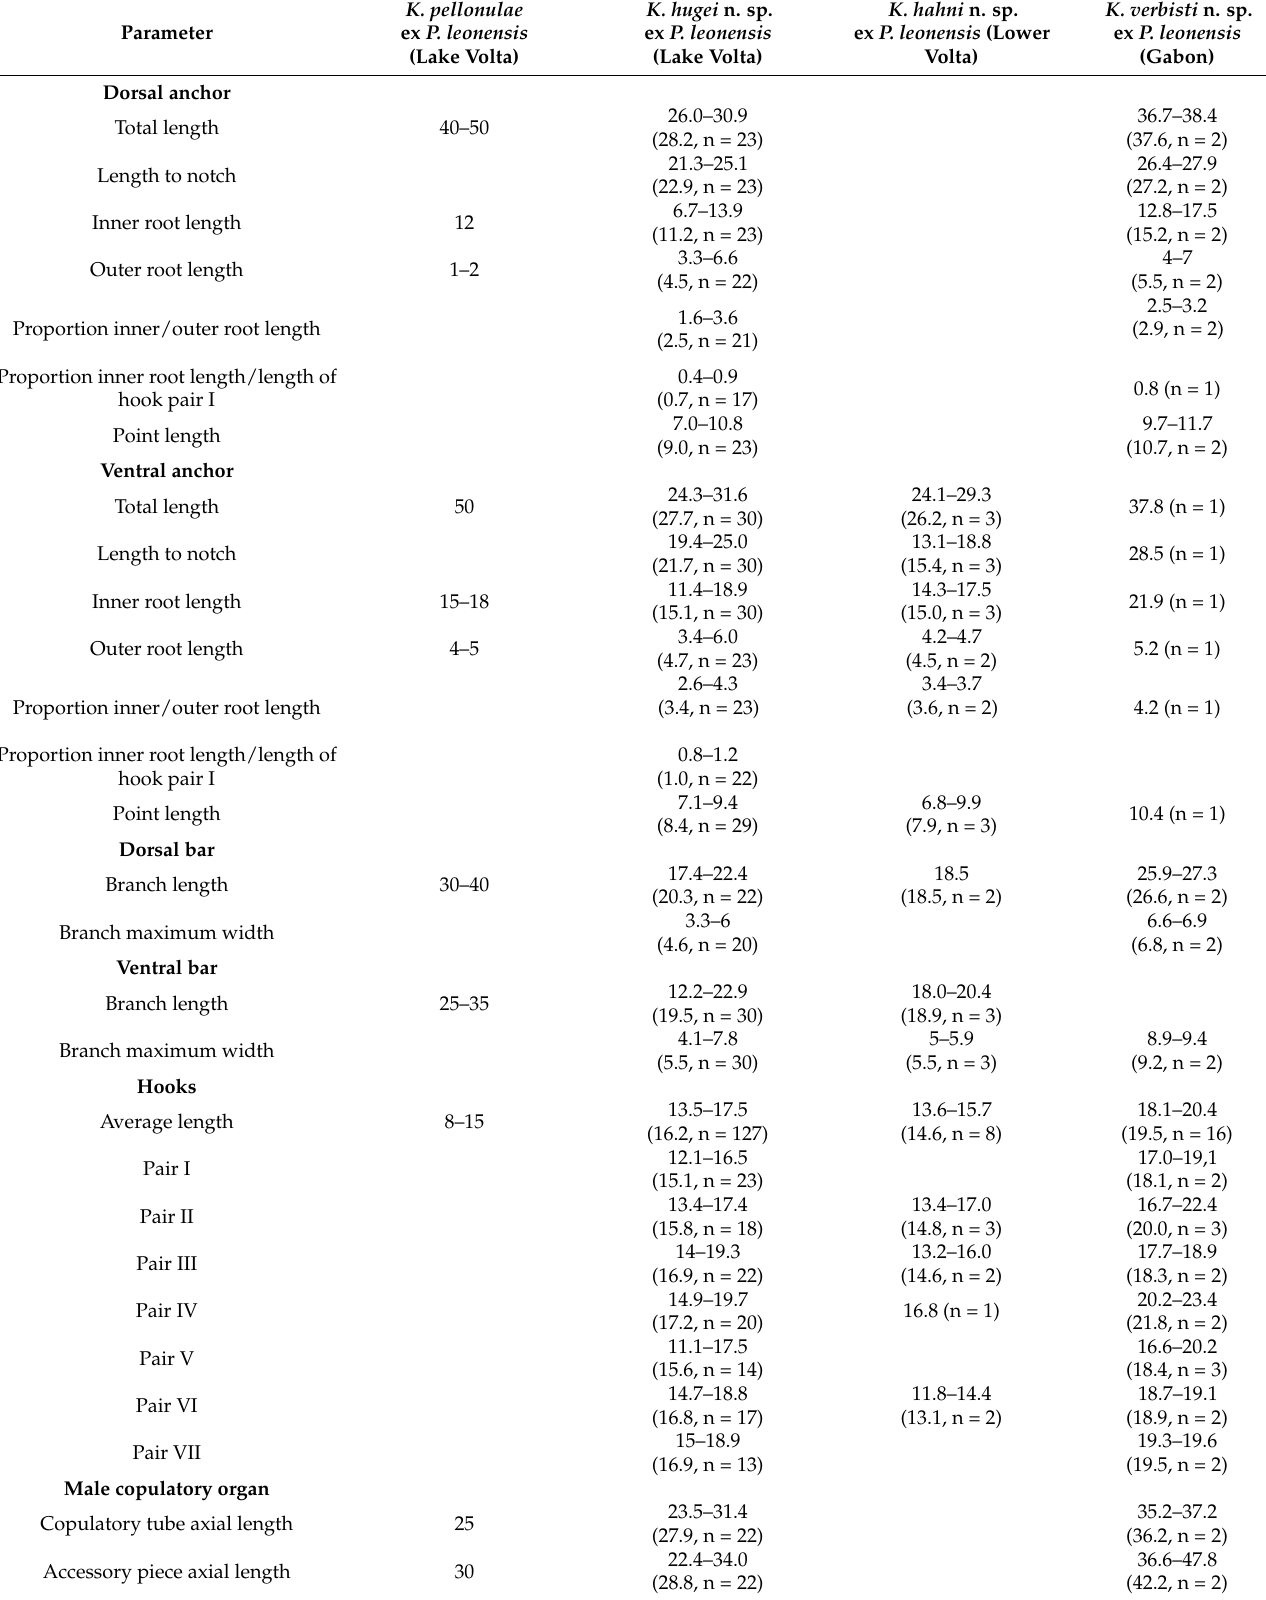
Table 3. Morphometric data ( µ m) for species of Kapentagyrus infecting Pellonula leonensis ; data for K. pellonulae from [32]. The measurements are presented as range followed by average and number of structures measured (n) in